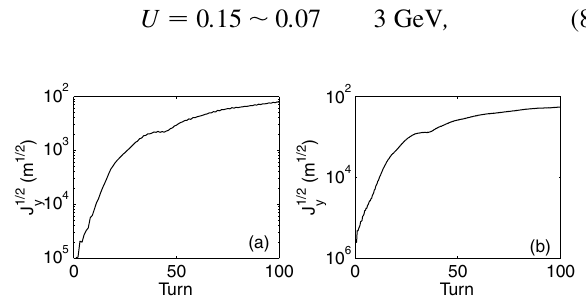
FIG. 8. Growth of the vertical dipole instability for J-PARC 3 and 50 GeV rings at injection. The right-left correspond to the head-tail of a bunch, respectively. (a) and (b) are obtained for 3 and 50 GeV, respectively.